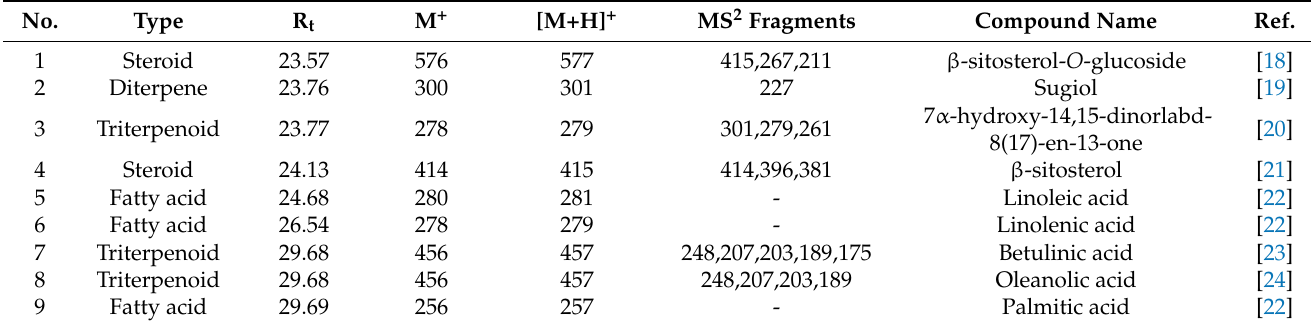
Table 1. Tentatively identified compounds in the light petroleum fraction of S. hispanica L. aerial parts.